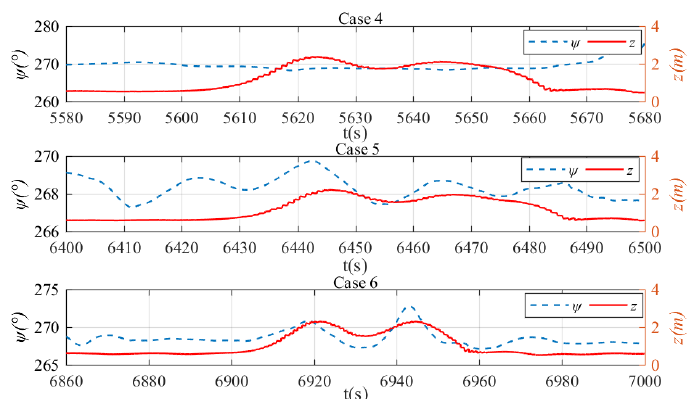
Figure 22. Results of depth and heading control with rudder jam. Heading and depth in case 4 (top), heading and depth in case 5 (middle), and heading and depth in case 6 (bottom).